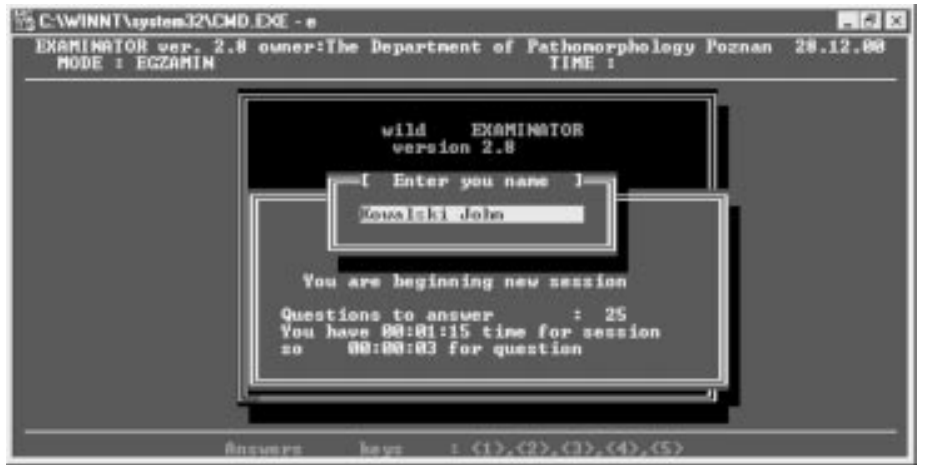
Fig. 4. Beginning of the exam with giving the family and first name. Below the information about conditions of an examination mode established by ASISTANT program is displayed.